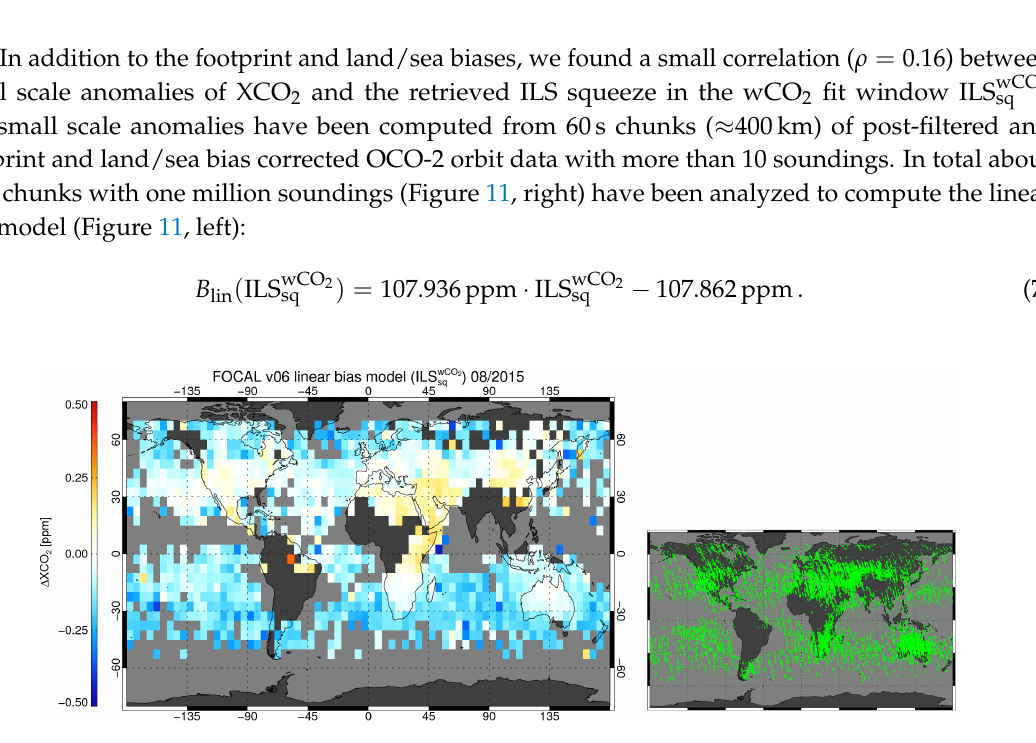
Figure 10. FOCALv06 land/sea bias pattern (Equation (6)) at the example of August 2015 ( left ) and sampling of soundings used to determine the land/sea bias ( right ).